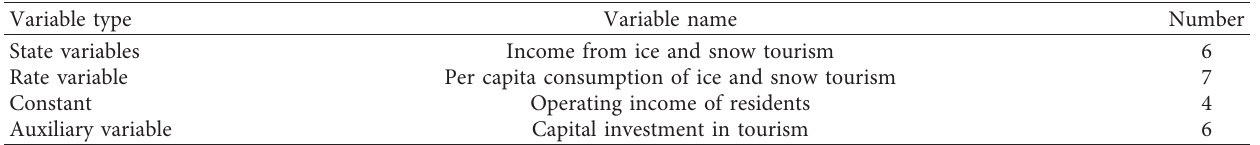
Table 1: Evaluation model main